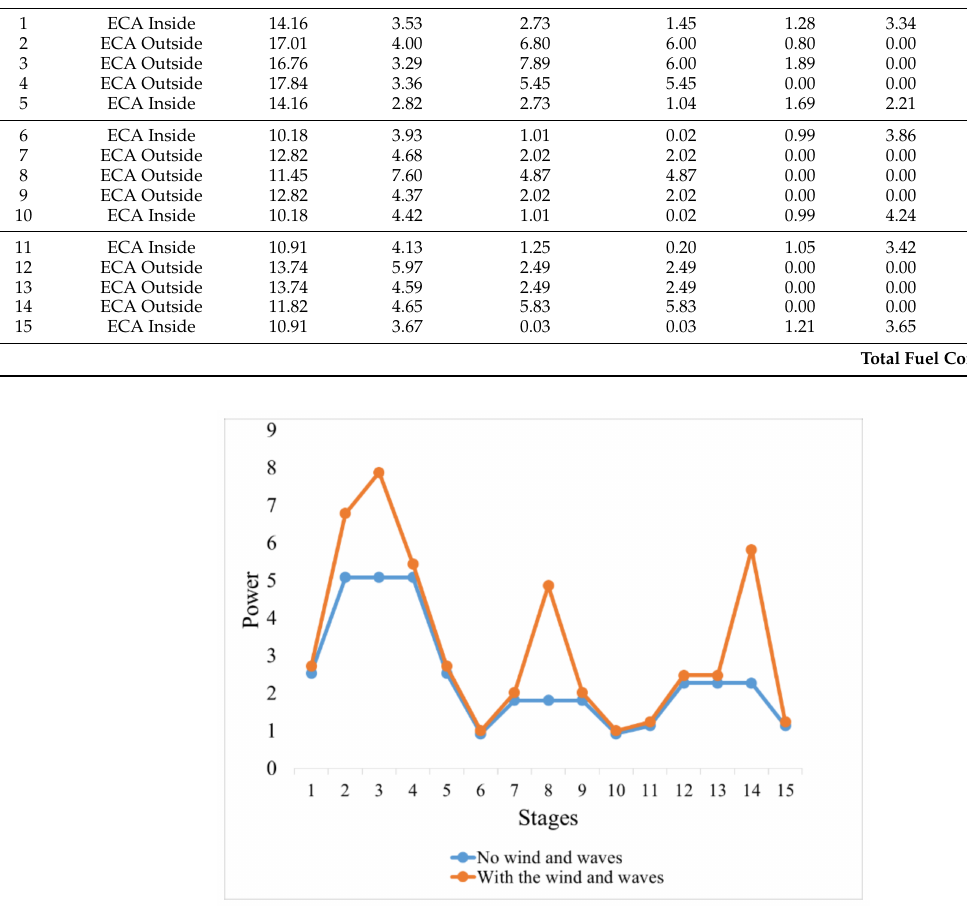
Figure 7. Comparison of propulsion power of a ship with or without wind and